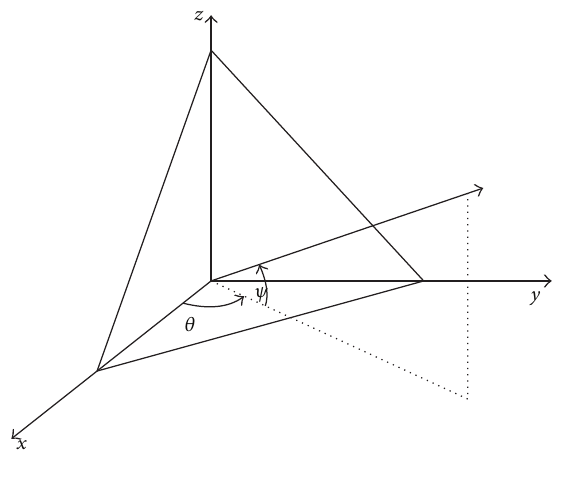
Figure 4: The azimuth angle (𝜃) and off-nadir angle (Ψ) defined for a corner reflector.